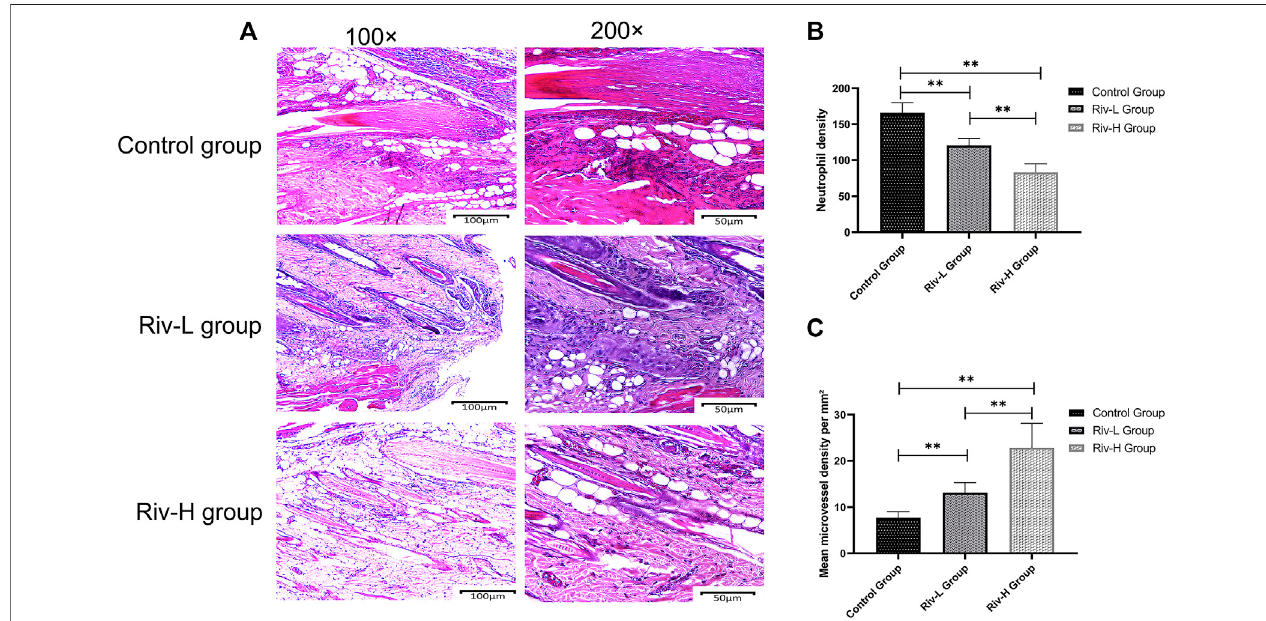
FIGURE3|(A) PathologicalcharacteristicsofH&Estainingofrandomskin fl apsinzoneIItissueofthethreegroupsrevealedbyopticalmicroscopy( × 100and × 200 magni fi cation). (B) Comparison of neutrophil density among the skin fl aps of the three groups. (C) Comparison ofmicrovessel density (MVD) among the skin fl aps of the three groups. The rivastigmine treatment groups showed signi fi cantly increased MVD compared to the control group. ** p < 0.01.